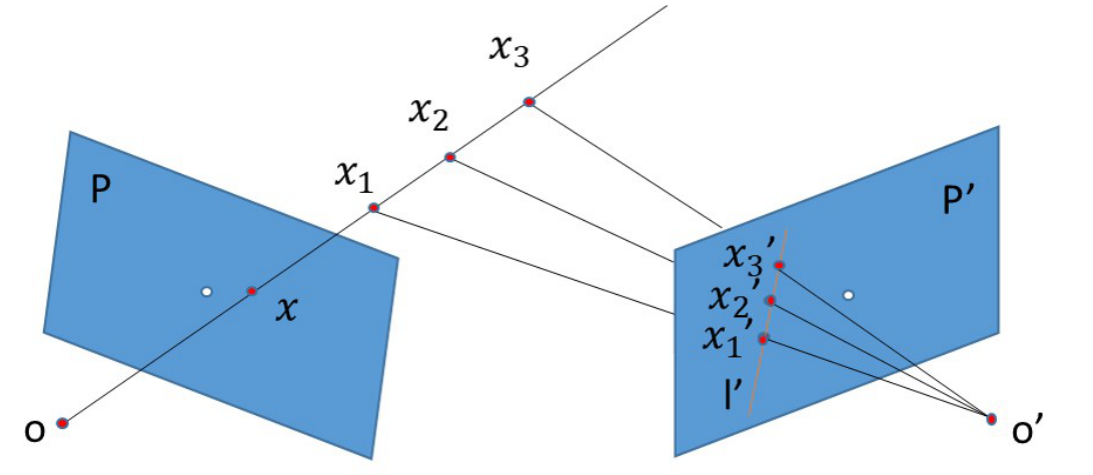
Figure 6. Matching principle of the Fundamental Matrix for